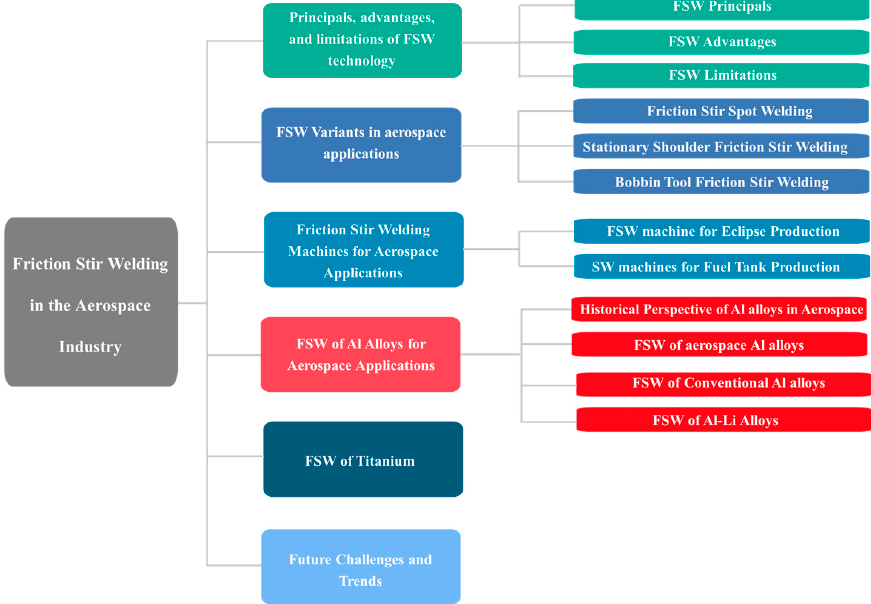
Figure 2. The structure of the current